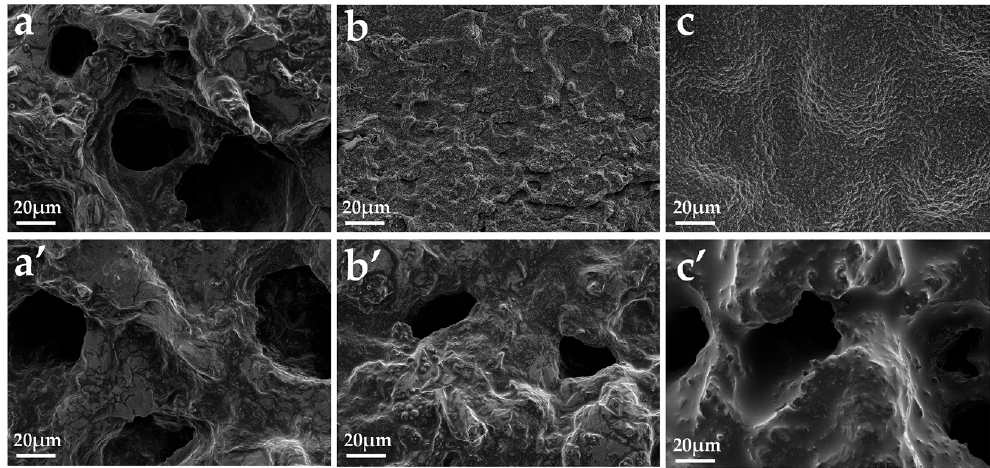
Figure 9. SEM images of char residues of PP/25%APP (( a ) outer, ( a’ ) inner), PP/22.5%MAPP (( b ) outer, ( b’ ) inner), and PP/25%MAPP (( c ) outer, ( c’ ) inner) after CCT. ( b’ ) inner), and PP / 25%MAPP (( c ) outer, ( c’ ) inner) after CCT.